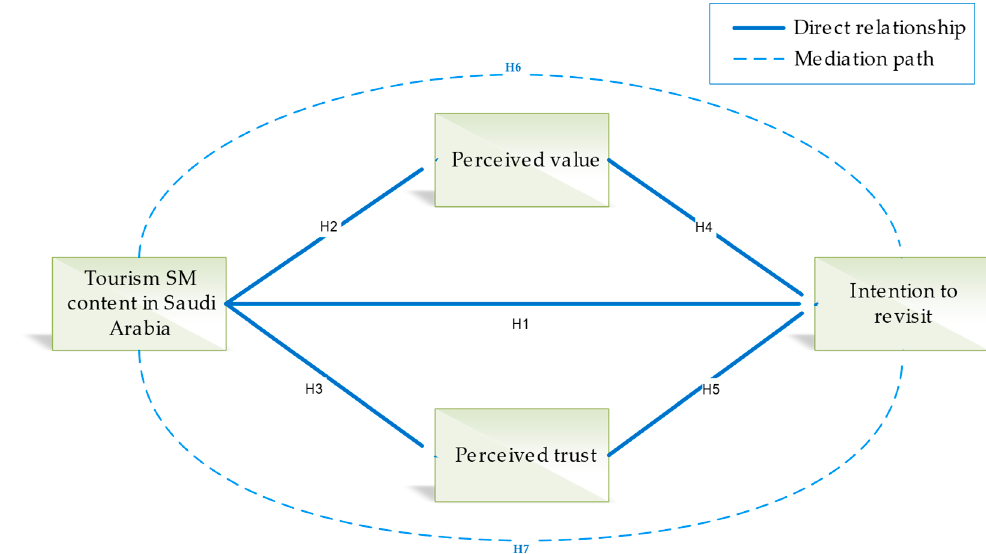
Figure 1. A framework of this study’s hypothesis. SM: social media.